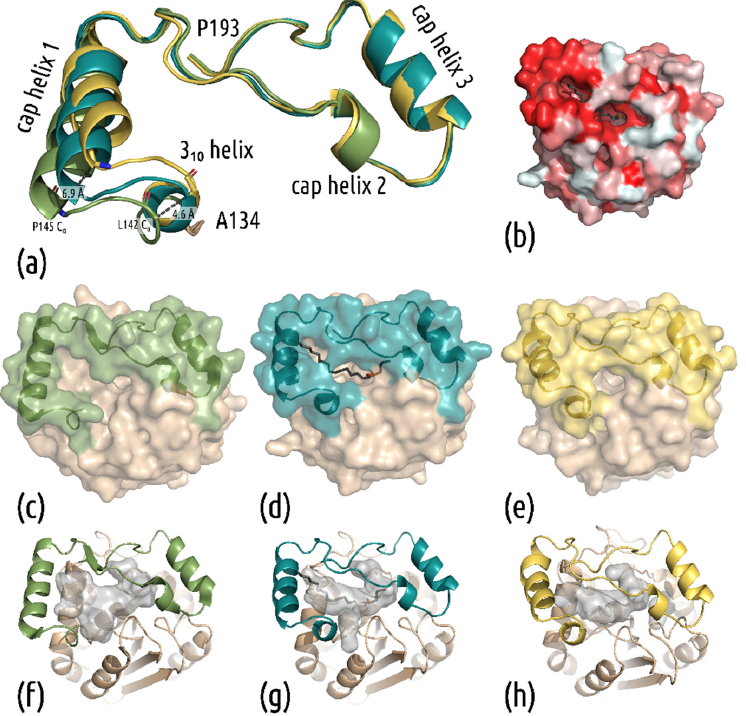
Figure 2. ( a ) Overlay of the three cap conformations from wt mtbMGL (green), the complex structure with Maglipan and mtbMGL K74A (teal), closed-cap conformation (yellow). ( b ) The complex structure of mtbMGL K74A with Maglipan in surface representation, colored by hydrophobicity (white hydrophilic, red hydrophobic, according to the Eisenberg hydrophobicity scale [41]. Surface representations of ( c ) wt mtbMGL, ( d ) complex structure, ( e ) closed-cap structure. Cavities are shown for ( f ) wt mtbMGL, ( g ) complex structure, ( h ) closed-cap structure. The cap domain is shown in different colors, the α / β hydrolase core fold in beige. (Figure 2). Without the substrate analog, mtbMGL K74A crystallized in a completely closed cap conformation. It can be seen in Figure 2 that the first helix of the cap domain (cap helix 1, Figure 2a) distorts and rolls over the entrance tunnel (Figure 2e). In the complex structure, cap helix 1 adopts an intermediate stage between the open and closed conformation. The ligand dives deeply into the lipase to the active site within the core domain, whereas the end of the alkyl chain still projects into the exterior of the substrate- binding cavity. We observed electron density throughout the entire substrate entrance tunnel of both chains, up to the active site Ser110, into which we could nicely fit the substrate analog Maglipan (Figure 1g). In comparison to the open-cap conformation of mtbMGL, the substrate-bound structure also shows changes in the cap domain. At the N-terminal end of the cap domain, the loop leading to the first helix forms a single turn of a 3 10 -helix in both structures of mtbMGL K74A. This change forces the N-terminal part of cap helix 1 toward the active site. In the closed-cap conformation, this leads to the contacts of cap helix 1 with the consecutive loop region (Gly160–Gln164). In the complex structure, the ligand is positioned between the mentioned parts of the cap domain. The comparison of the different structures is shown in Figure 2. The aligned cap domains depict the rolling distortion of the helix (Figure 2a). Due to this movement, a substrate can either have full